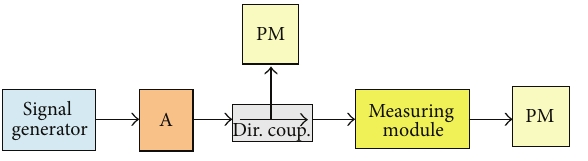
Figure 3: Schematic of experimental set-up. Signal generator: A: attenuator; Dir. coup.: directional coupler; measuring module; PM: power meter.